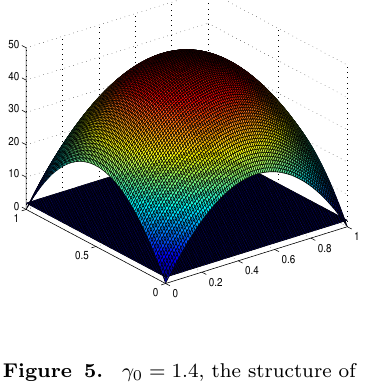
Figure 6. γ 0 = 1 . 4, the structure of solutions at t =